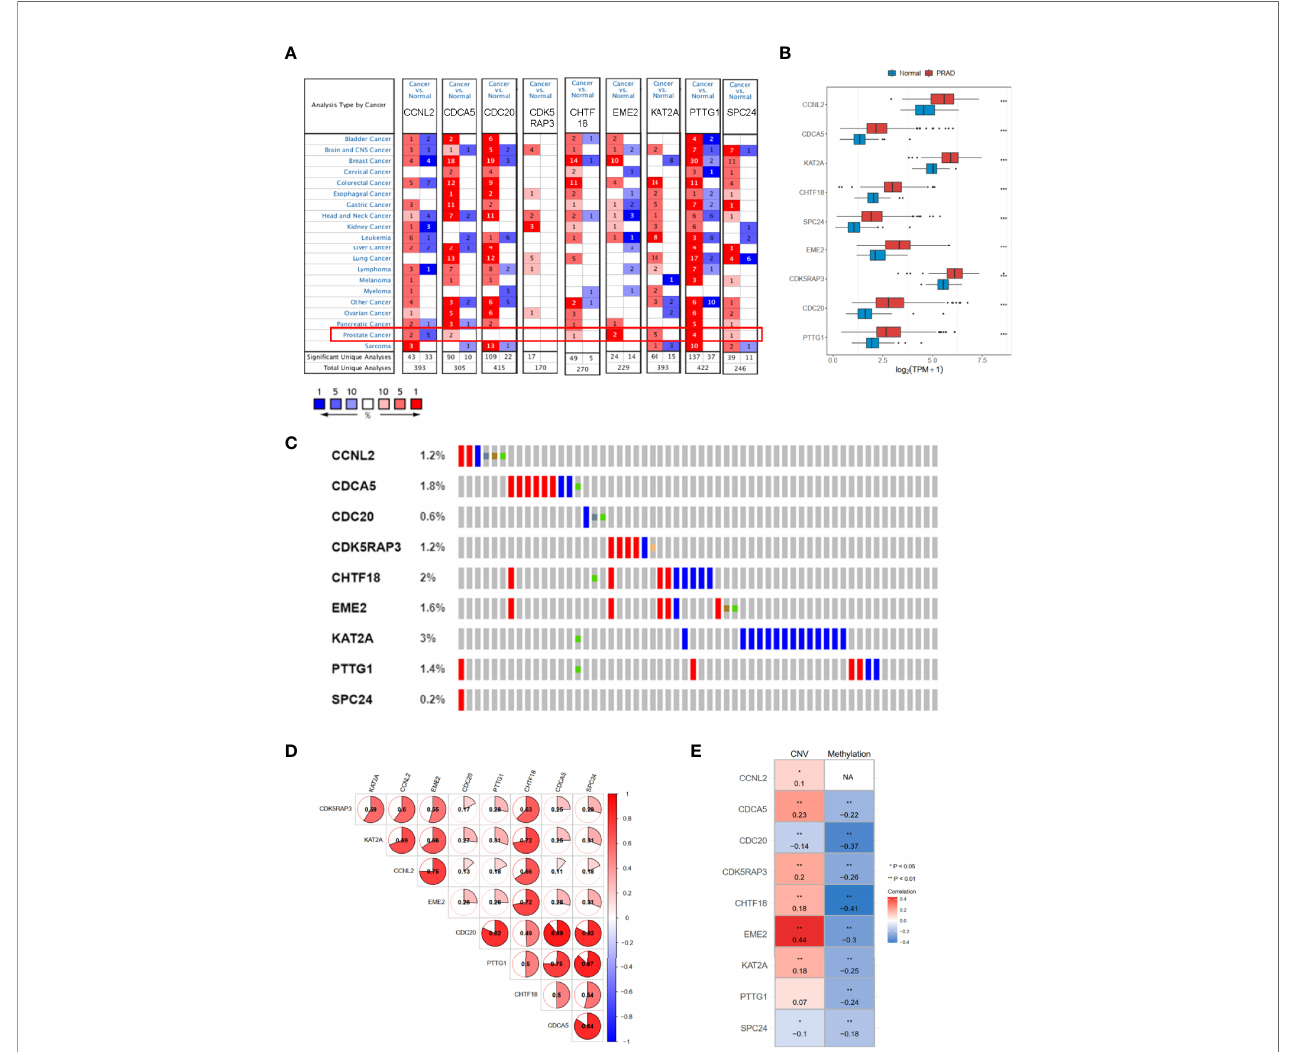
FIGURE 8 | The mRNA expression patterns, genomic alterations, and methylation of nine hub genes. (A) The overview of nine hub genes in the Oncomine database. (B) The mRNA expression pro fi les of nine hub genes in TCGA-PRAD. (C) The genetic alterations of nine hub genes based on cBioPortal. (D) The correlations between these nine hub genes. (E) The correlations between mRNA expression and methylation, and copy number variation of nine hub genes. TCGA-PRAD, The Cancer Genome Atlas-Prostate Cancer. NA, not avaiable. * p < 0.05, ** p < 0.01, *** p <